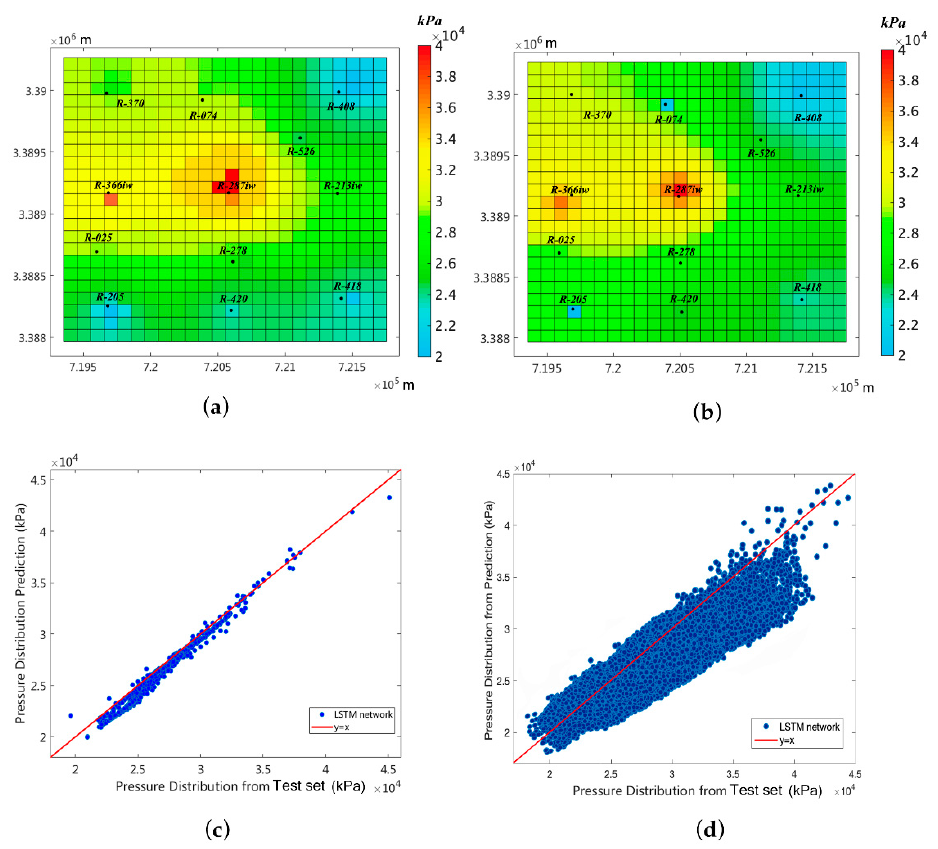
Figure 11. Comparison between Test set data and LSTM results at 48th month of prediction (148th month in whole time sequence) for pressure distribution: ( a ) Pressure distribution from Test set; ( b ) Pressure distribution from LSTM prediction; ( c ) Cross plot of pressure distribution for 22nd layer; ( d ) Cross plot of pressure distribution for all layers.